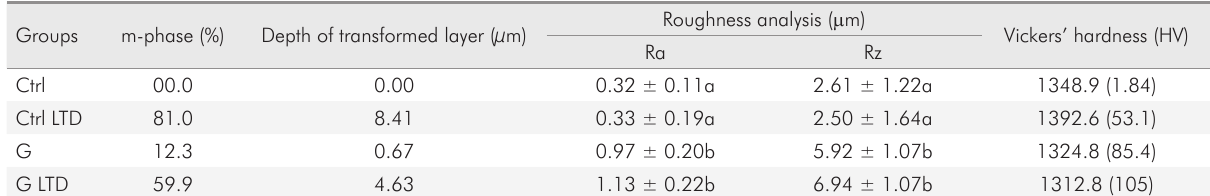
Table 2. Percentage of monoclinic phase, depth of transformed layer, roughness data (mean ± SD) for Ra and Rz parameters, Vickers hardness.